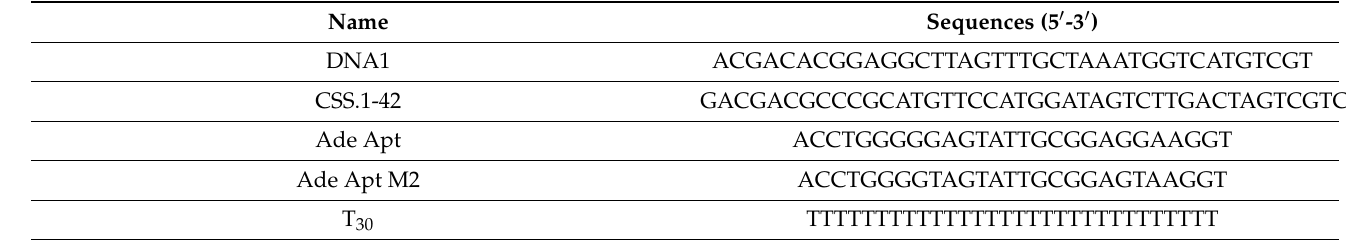
Table 1. DNA sequences and modifications used in this